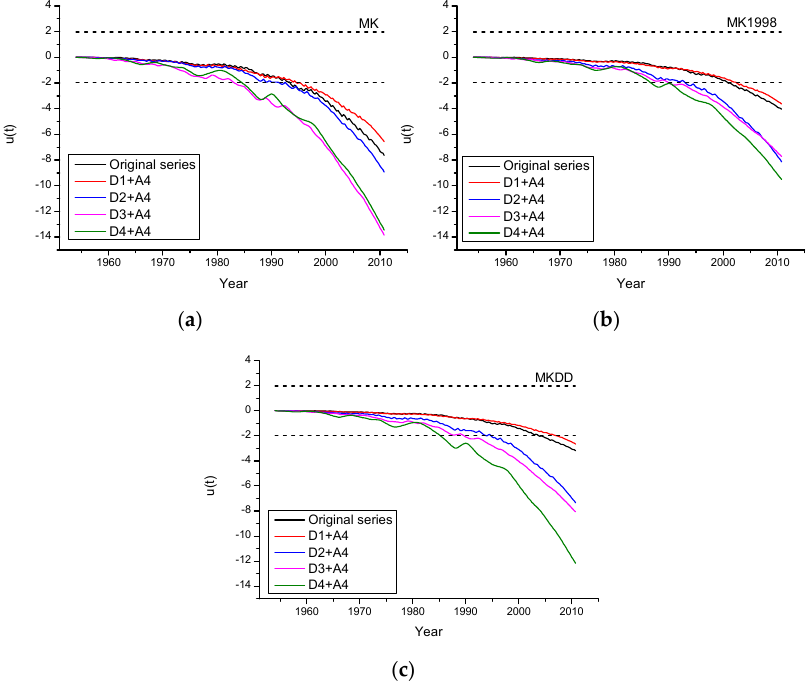
Figure 12. Three sequential Mann-Kendall graphs of seasonal mean streamflow series exhibiting the progressive trend lines of each detail component (with the addition of the approximation) with respect to the original series. The upper and lower dashed lines represent the confidence limits ( α = 5%). ( a ) MK; ( b ) MK1998; ( c ) MKDD.